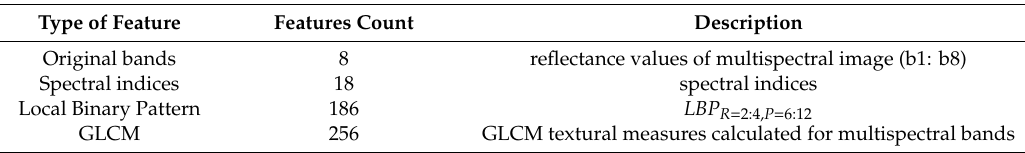
Table 5. Extracted features from the multispectral